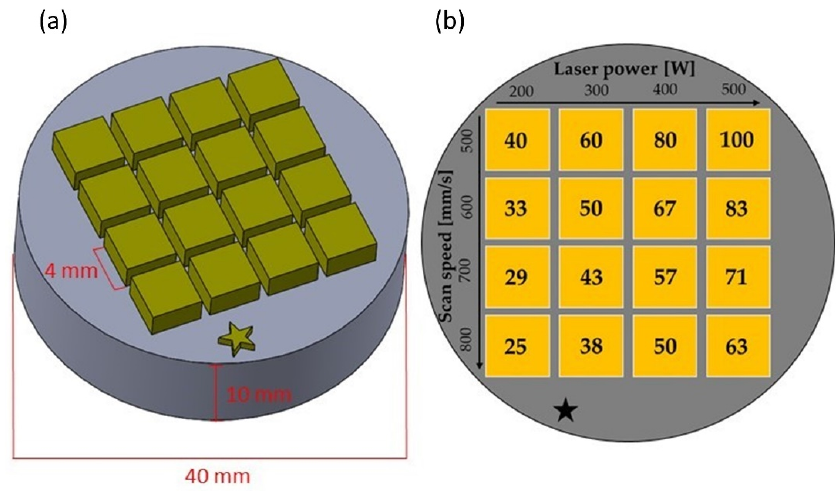
Figure 3. ( a ) CAD-model of the additively manufactured samples on the substrate plate. ( b ) Parame- ter study. The values in the yellow squares indicate the resulting volumetric energy density ( VED in [J/mm³]) for the respective sample.